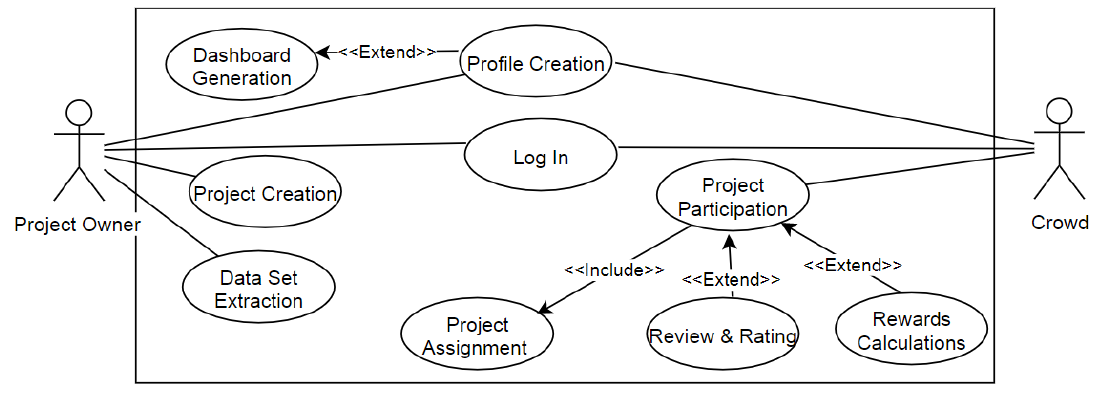
Figure 1. Tashkeel’s core function in a use case diagram.